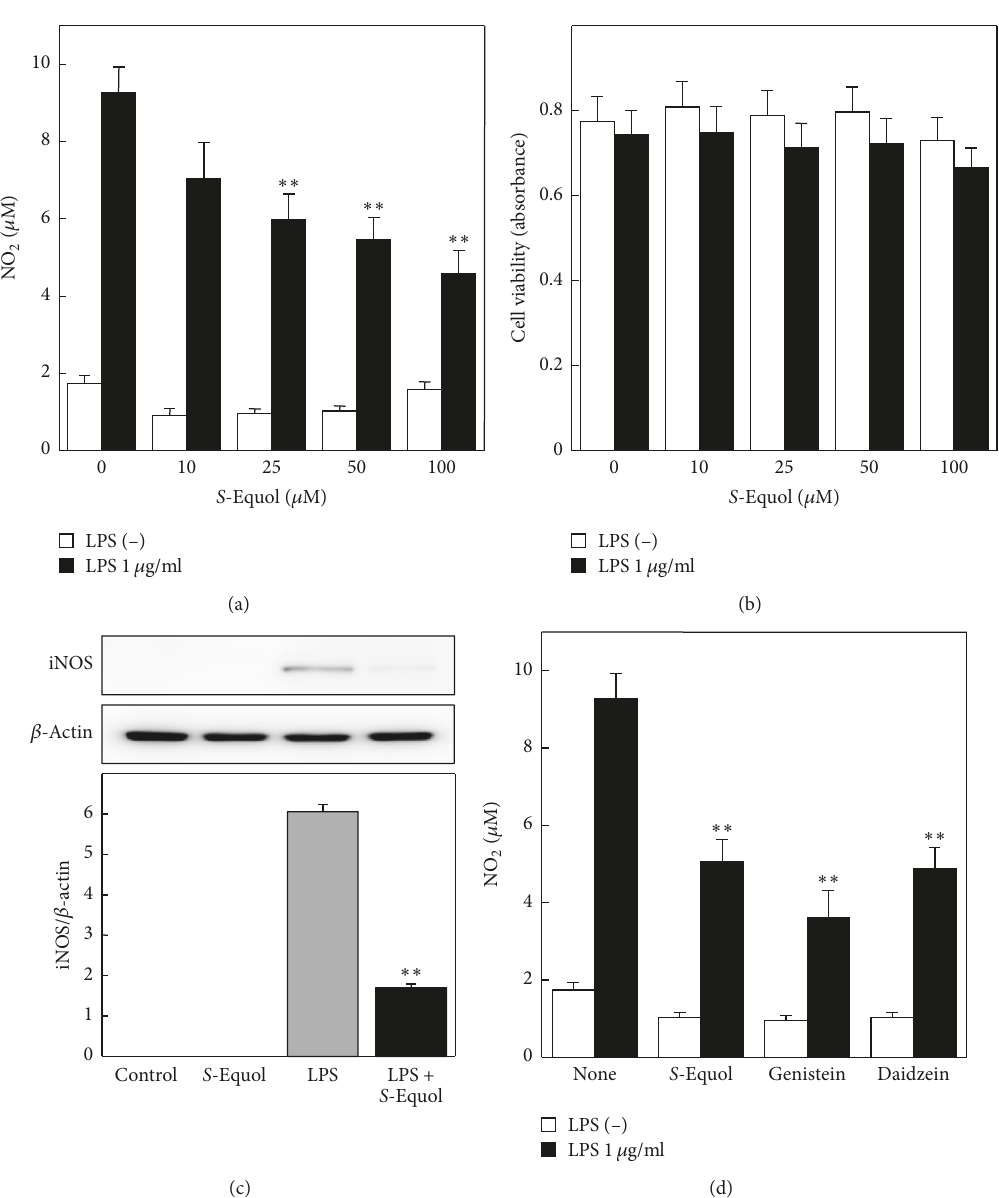
Figure3:Effectof S -equolonLPS-inducedNOproduction,cellviability,andexpressionofiNOSprotein.Culturedastrocyteswerestimulated with 1 𝜇 g/ml LPS for 24h in the presence of various concentrations of S -equol. The nitrite concentration in the medium was measured fluorometrically (a), and cell viability was evaluated with the MTT assay (b). The cells were treated with 1 𝜇 g/ml LPS in the absence or presence of 50 𝜇 M S -equol for 24 h. The expression of iNOS protein was detected with western blotting (c). Effect of isoflavones ( S -equol, genistein, and daidzein, each concentration of 50 𝜇 M) on LPS-induced NO production (d). Data are the mean ± SEM of 5-6 samples. ∗∗ 𝑝 < 0.01 significantly different from 1 𝜇 g/ml